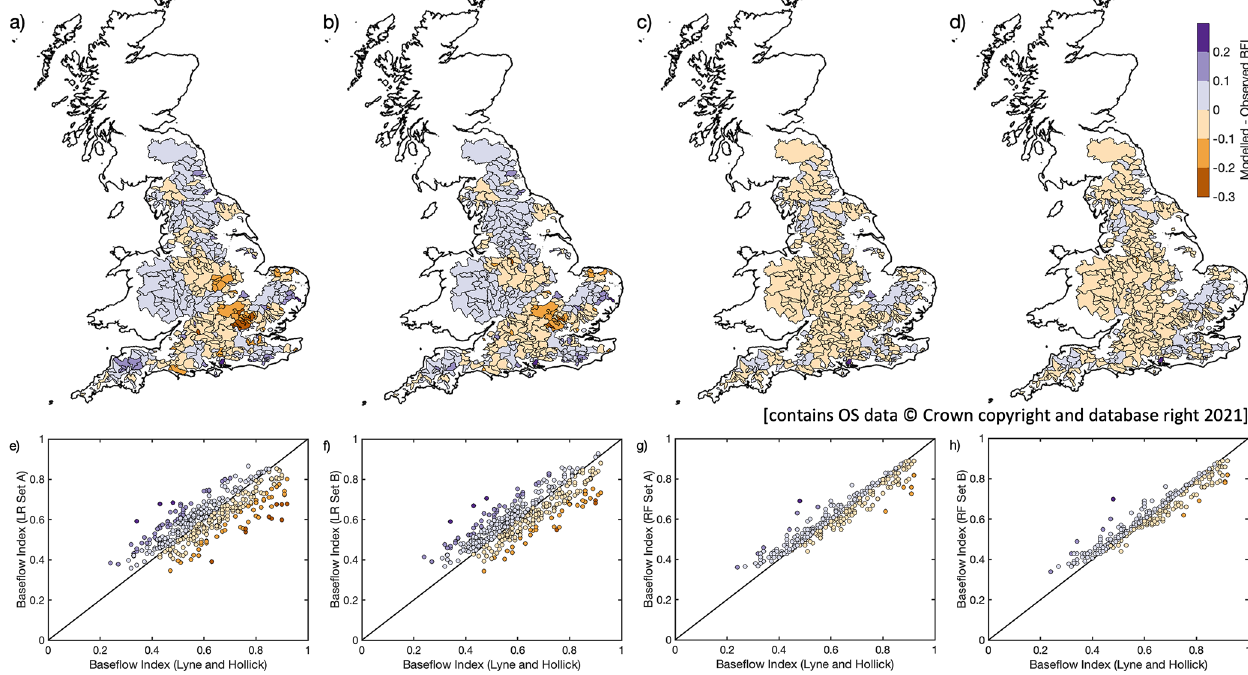
Figure 6. Maps of difference between modelled and observed BFI_LH (a–d) and corresponding scatter plots of BFI_LH against fitted BFI (e–h) for covariate Sets A and B for LR and RF models (Models 1, 5, 3, and 7 respectively).